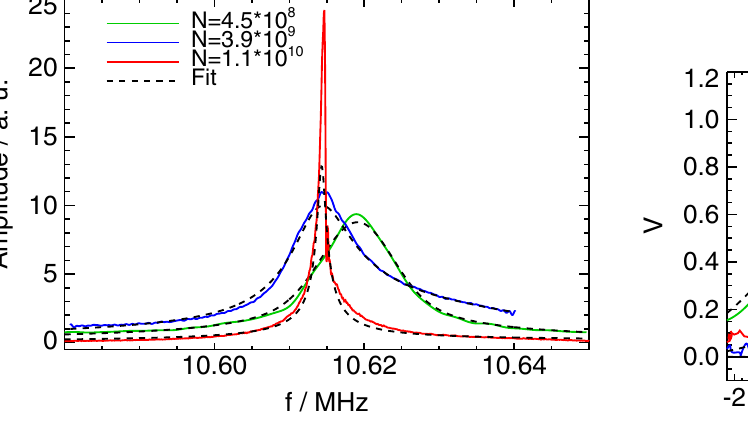
FIG. 3. (Color) Amplitude of the BTF for different currents. The settings are the same as in Fig. 2. (cid:1) U sc found for these data are 0., 0.9, and 2.7. Also the fits are shown.